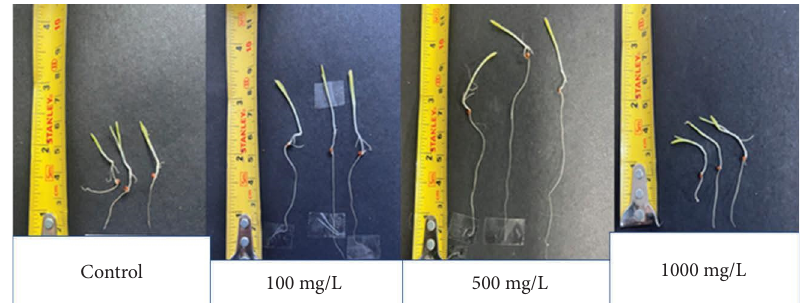
Figure 7: Efect of zinc oxide nanoparticles (ZnO NPs) on the growth of Eleusine coracana seedlings.